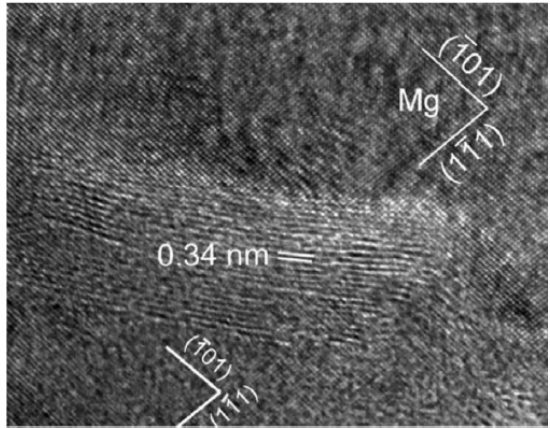
Figure 11. High-resolution transmission electron microscopy (HRTEM) micrograph of the GNPs incorporated in the Mg matrix [61] (Copyright Elsevier, 2012, Scripta Materialia). Rashad et al. [58,59,63,181,182] have fabricated an Mg-(10Ti + 0.18 wt.% GNPs) nanocomposite,